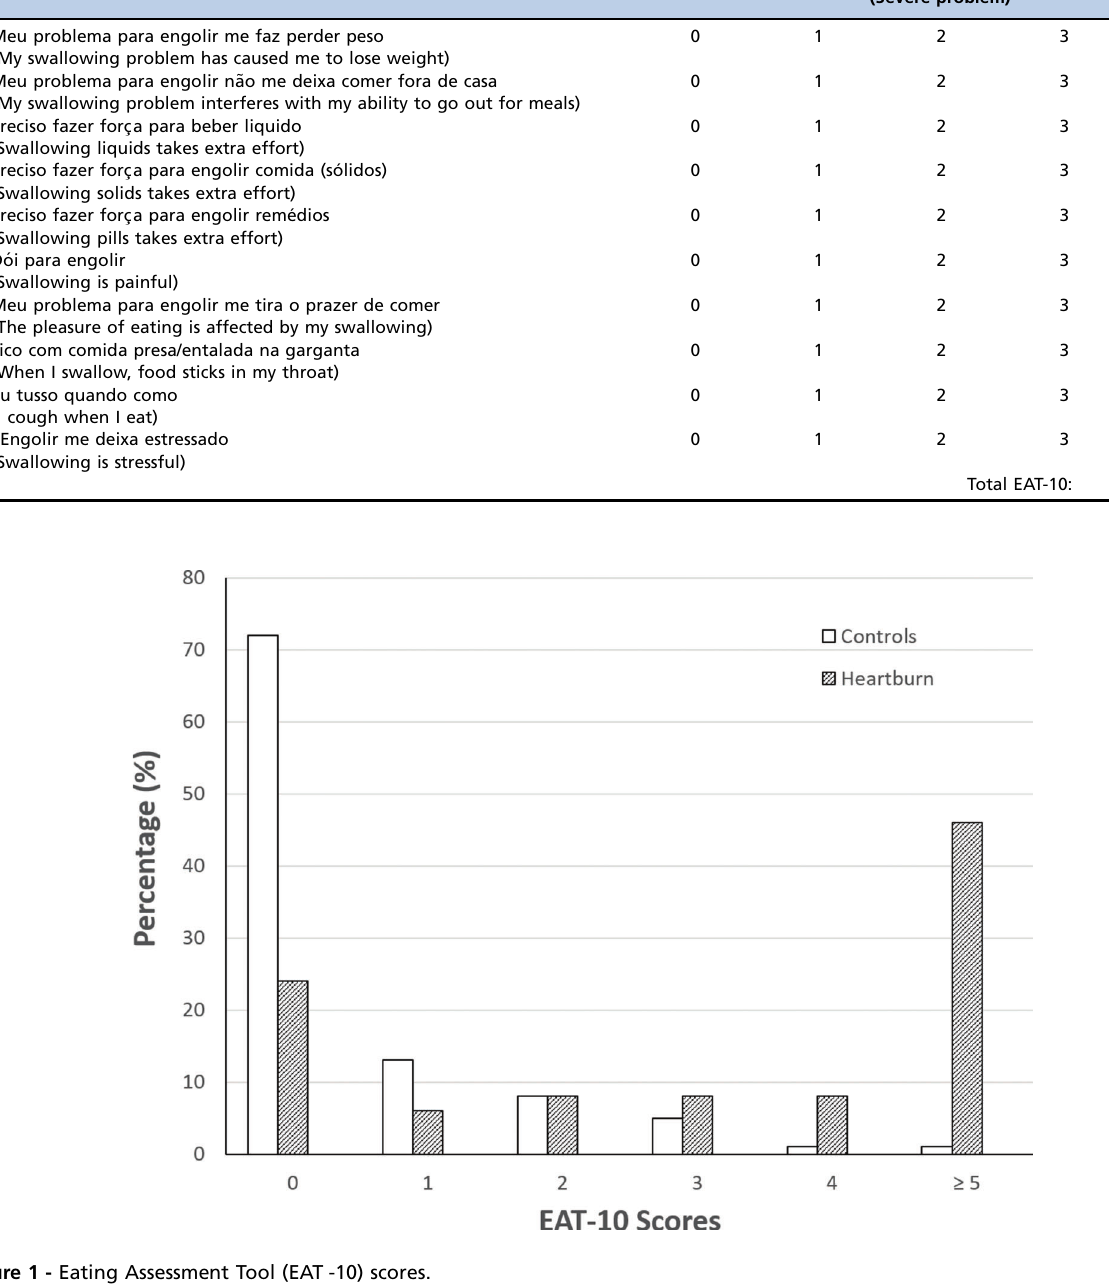
Figure 1 - Eating Assessment Tool (EAT -10)